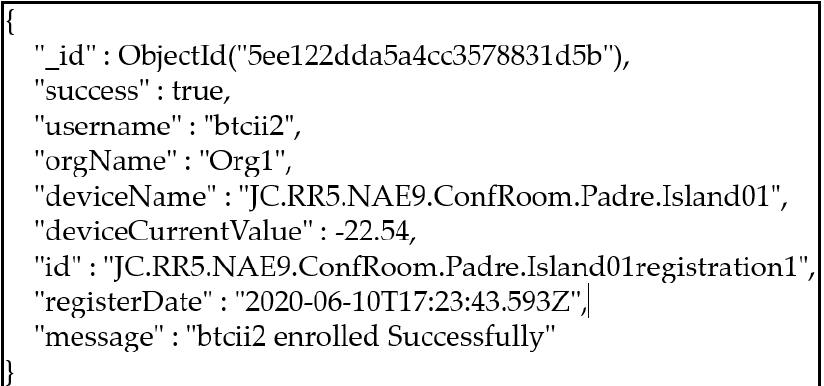
Figure 7. EdgeX usercreater UI and registered devices.